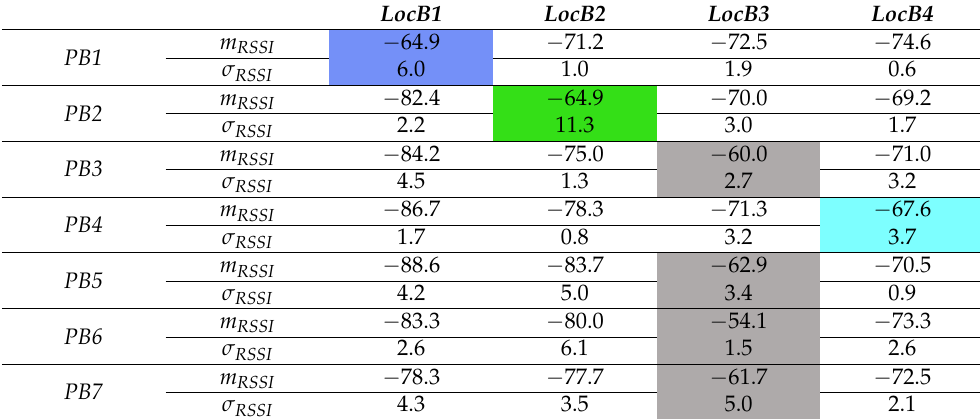
Table 2. Mean values ( m RSSI ) and standard deviations ( σ RSSI ) of the RSSI for different LocBn–PBm combinations. The colored cells represent the nearest locator node to the PBm location, where: LocB1 (blue), LocB2 (green), LocB3 (grey), LocB4 (cyan). LocB1 LocB2 LocB3 LocB4 m RSSI − 64.9 − 71.2 − 72.5 − 74.6 PB1 σ RSSI 6.0 1.0 0.6 m RSSI − PB2